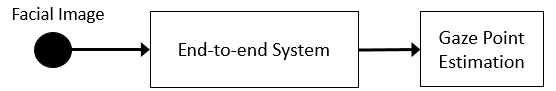
Figure 6. Scheme of end-to-end system from the analysis of the